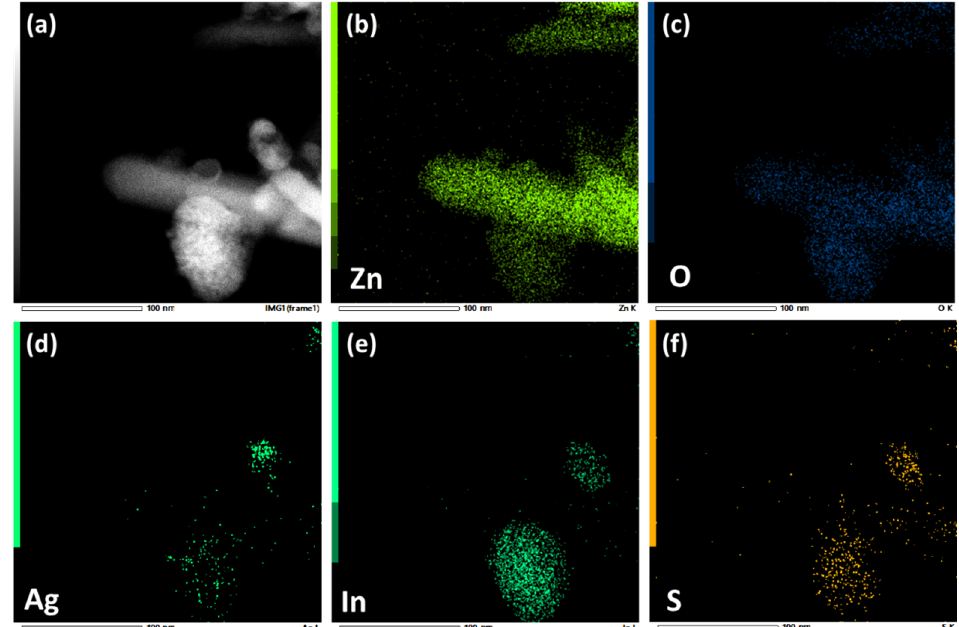
Figure 2. ( a ) High-angle annular dark field (HAADF) STEM images of the ZnO/AIZS(10) heterostructured photocatalyst and the corresponding EDX mapping of ( b ) Zn, ( c ) O, ( d ) Ag, ( e ) In and ( f ) S elements, respectively.